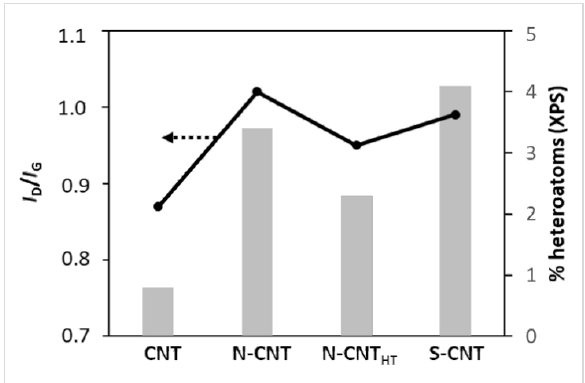
Figure 2: Evolution of the I D / I G ratio (from Raman spectroscopy) and the percent of surface heteroatoms (from XPS) in the investigated CNT